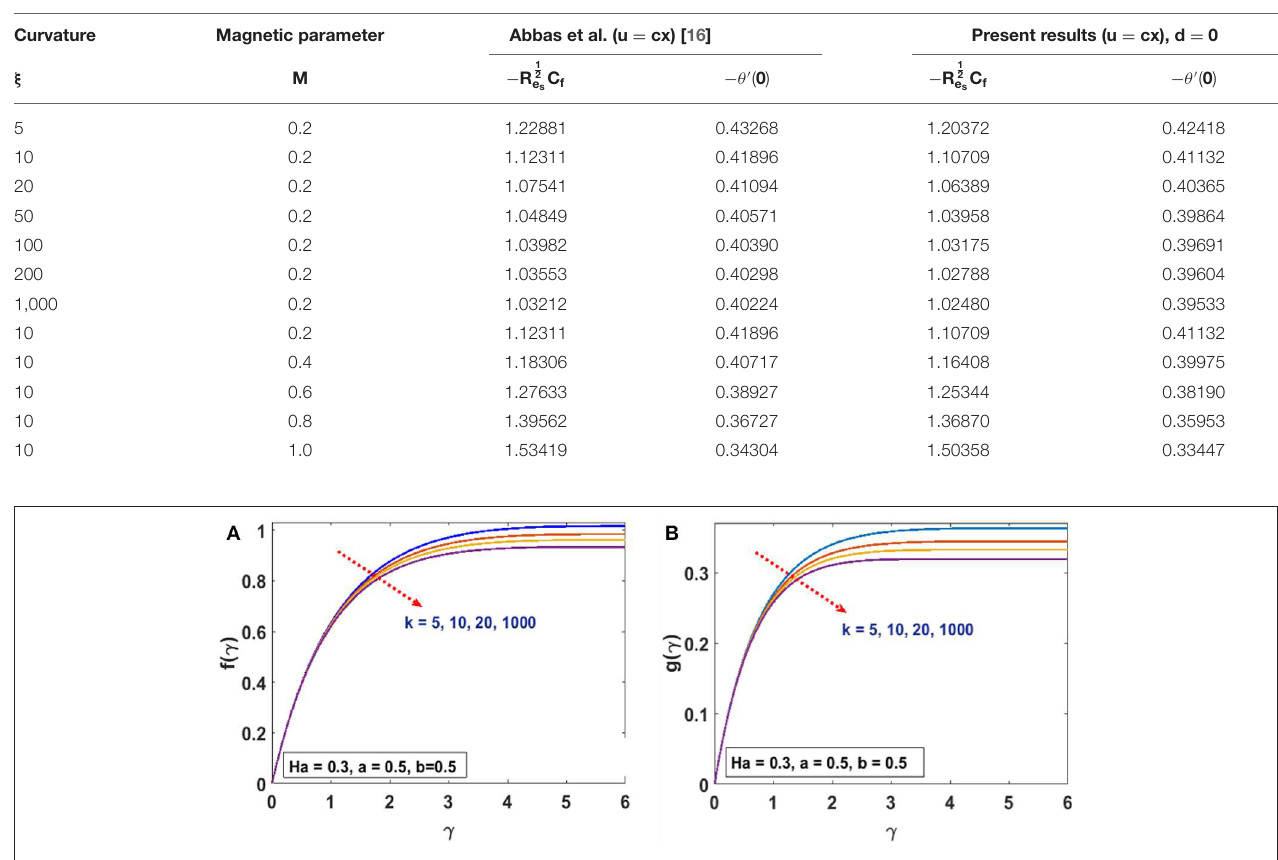
TABLE 1 | Comparison of the present results of the Skin-friction coefficient and the Local Nusselt number. Curvature Magnetic parameter Abbas et al. (u = cx) [16] Present results (u = cx), d = 0